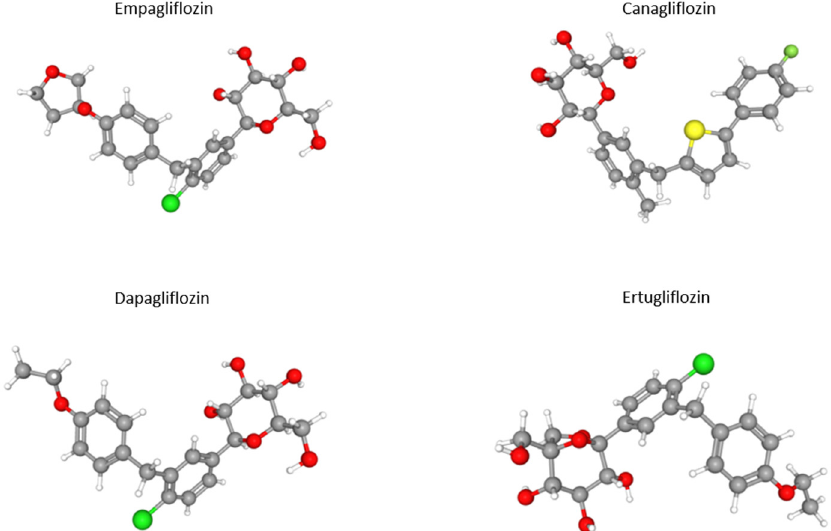
Figure 1. Three-dimensional structure of clinically used SGLT2 inhibitors [10]. Gray_carbon; red—oxygen; green—chloride; yellow—sulphur.